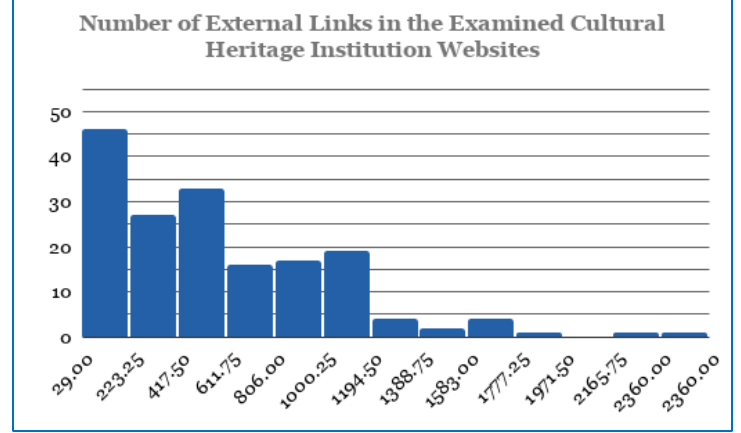
Figure 4. In contrast with the internal links, this histogram indicates that most of the cultural heritage institution websites do not contain a large number of external links inside their websites that allow users to navigate outside of them. Indeed, 45 of the total 171 websites ranged from 29 up to 223 external